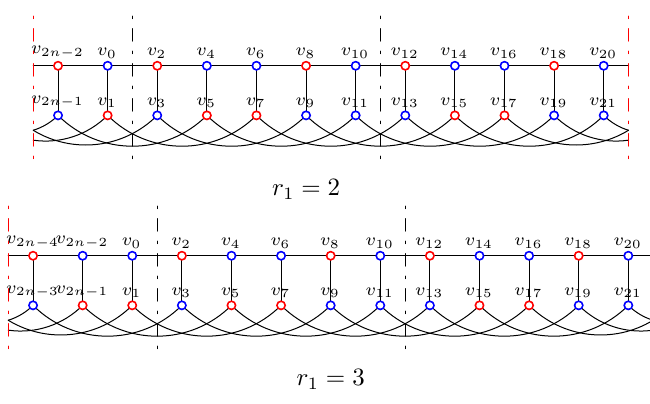
Figure 15. Segments of f in Case 3 in Lemma 8.